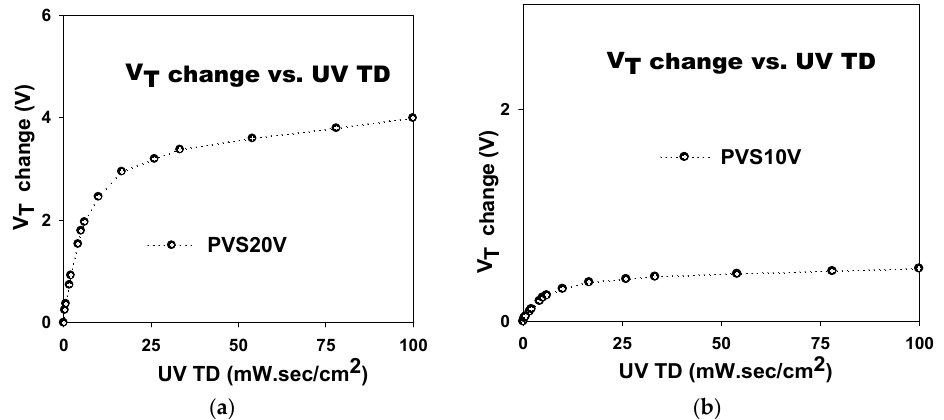
Figure 3. The dependence of the V T increase on UV irradiation TD for an F-SOHOS capacitor ( a ) under gate PVS 20V; ( b ) under gate PVS 10